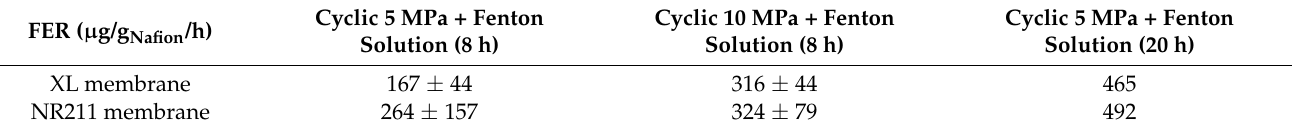
Table 2. Evolution of the fluoride emission rate as a function of the severity of conjoint mechanical and chemical stress exerted on Nafion ™ XL and NR211 membranes. Part of the data presented here has been already published in a previous work [2] but the values have been corrected here by taking into account the parasitic contribution of the TISAB II solution used for the measurements.